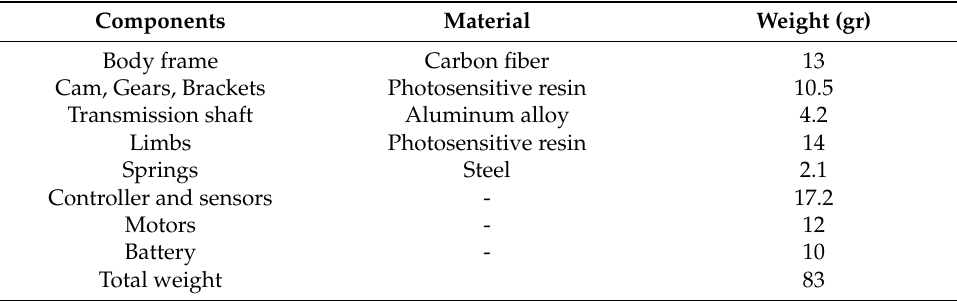
Figure 22. Prototype of the jumping robot inspired by flying squirrels. ( a ) The robot at fully flexed position; ( b ) the robot at fully extended position. Table 2. Materials and weights of the prototype components.